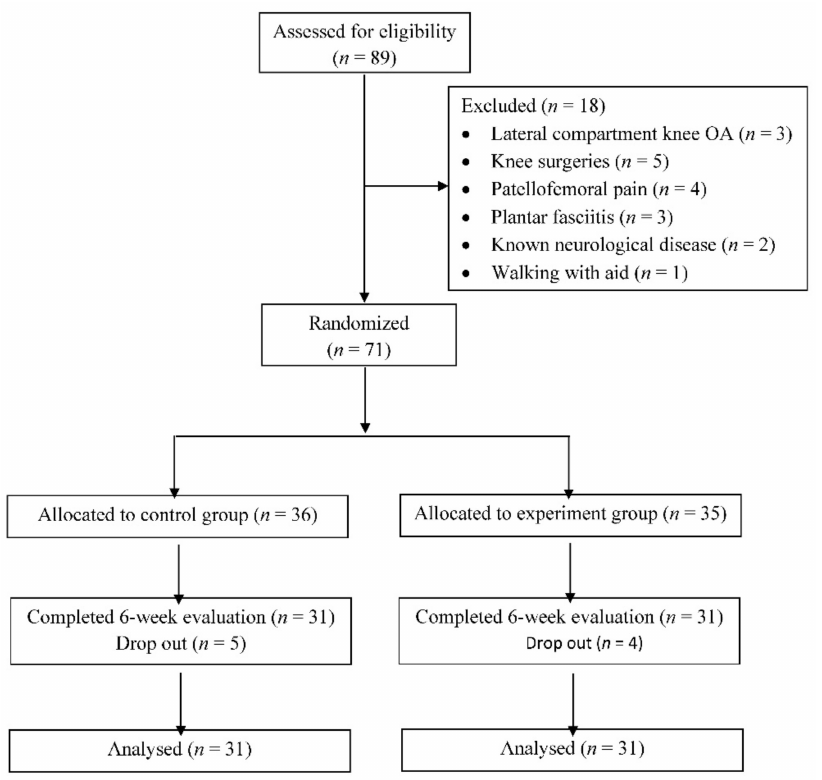
Figure 3. CONSORT flow